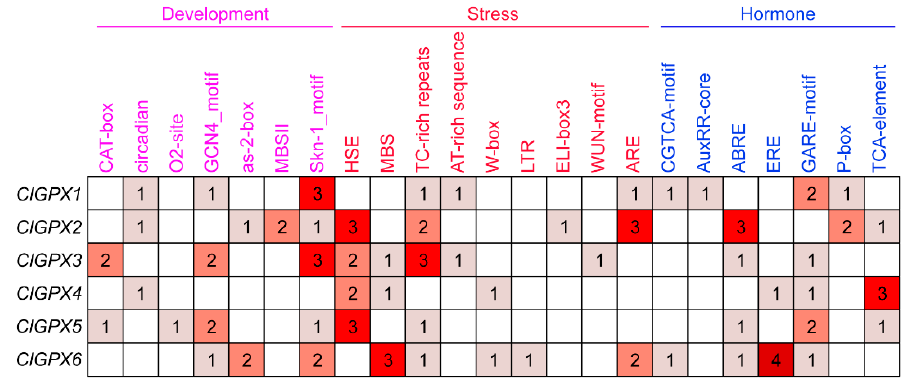
Figure 5. Prediction of cis ‐ acting regulatory elements present in the promoters of ClGPX genes.